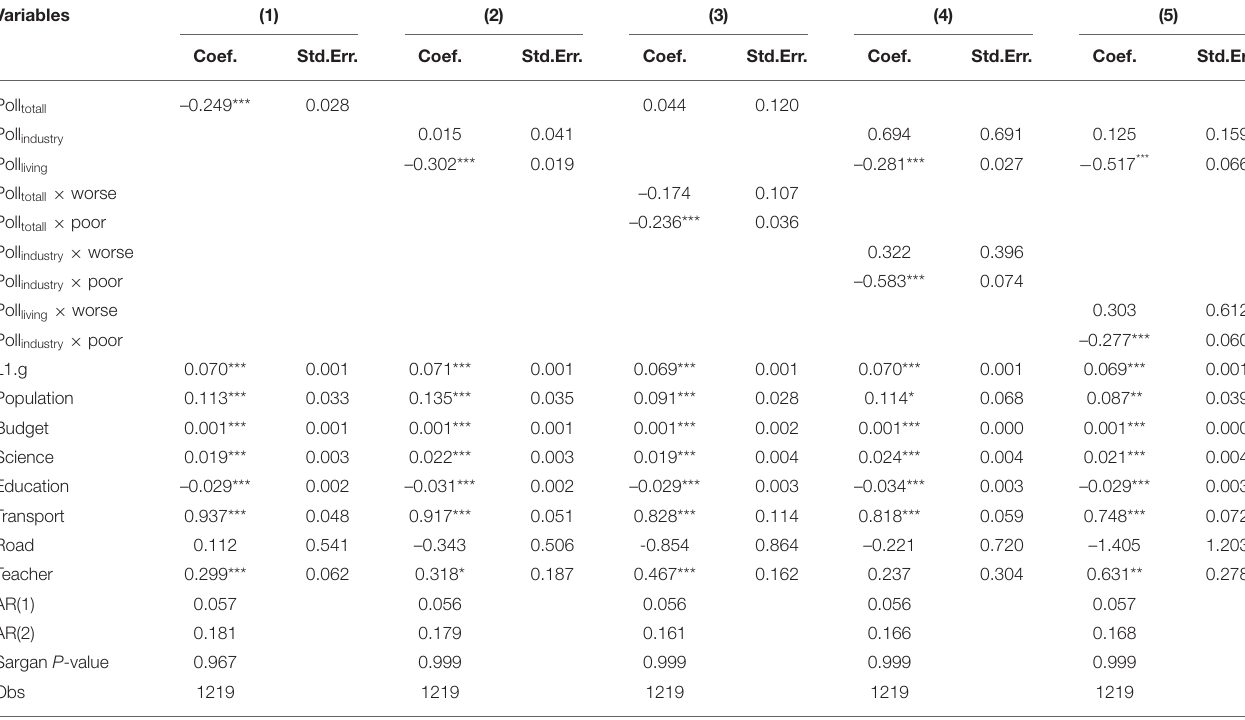
TABLE 4 | Estimated results of the impact of environmental pollution on the volume of output growth. Variables Coef. Std.Err. Coef. Std.Err. Coef. Std.Err. Coef. Std.Err. Coef.